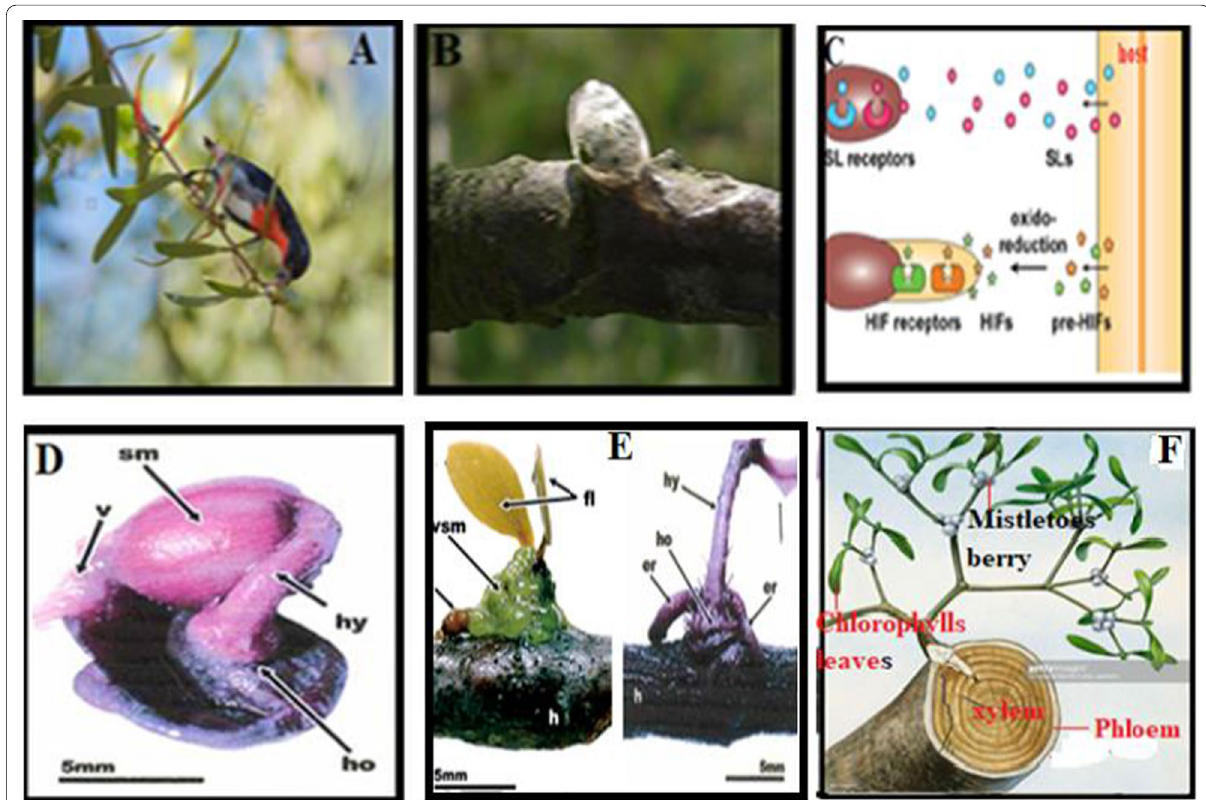
Fig. 2 An illustration of the haustorium germination of aerial mistletoes ( Decaisnina brittenii and Amylotheca dictyophleba, Loranthaceae) showing their developmental stages. A Mistletoe bird eats the mistletoe berries. B The seed passes safely through a bird’s gut (its body is aligned along the twig and carefully wipes its bottom on the bark beneath) yet stick to branches by mechanical pressure and cements copious viscin to the host branch. C Resembles the other parasitic flowering plants, the strigolactones (SLs) perception by SL receptors triggers the germination of haustorium. D , E Early germination stage; seed mass (sm) attached to host with viscin-covered seed mass (vsm/v), with long hypocotyl (hy) and holdfast (ho) separately attaching to host; later stage, hypocotyl extending, cotyledons emerged, first foliage leaves (fl) produced and establishment of seedling with epicortical root (er) called haustorium and F the mistletoe haustorium has connected with the host xylem inside the branch (figure modified after Ko et al. 2014; Saucet and Shirasu 2016; https:// askna ture. org/ strat egy/ sticky- berri es- adhere- 2/ Accessed 1 May